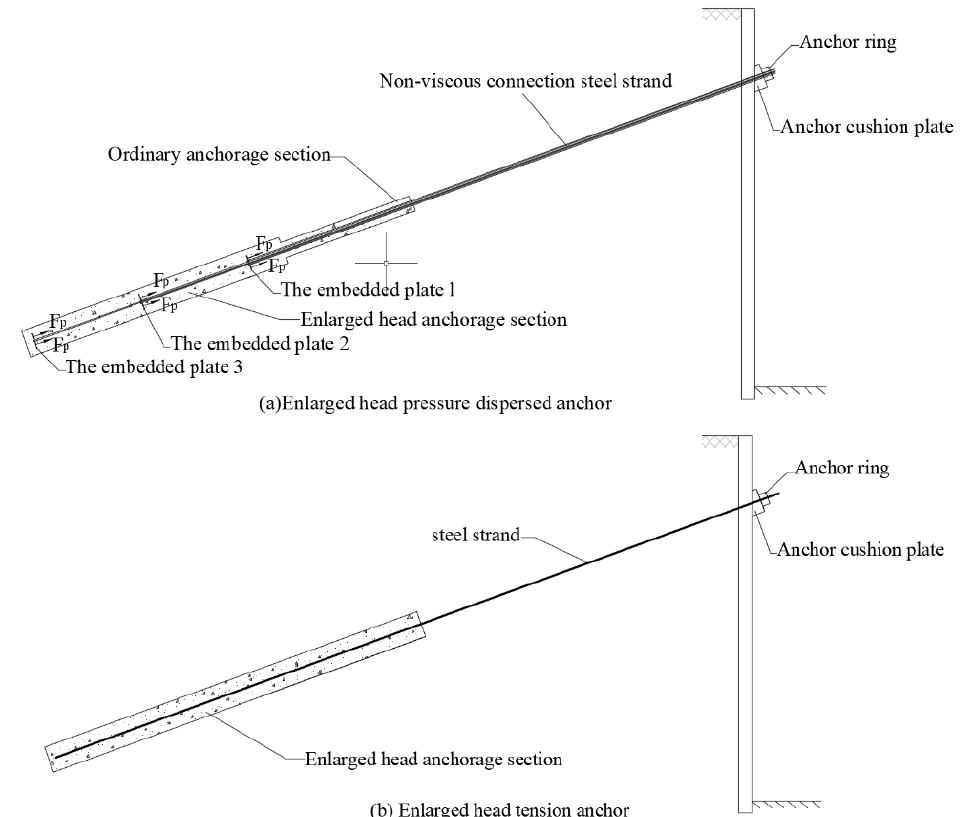
Figure 2. Pile–anchor supporting structure.